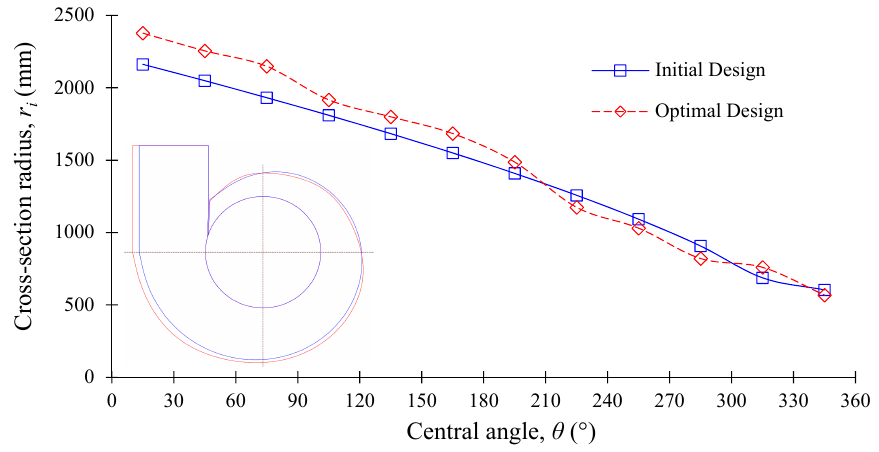
Figure 18. Comparison of initial and optimal casing design for the 100 MW class Francis turbine. Table 10. Results of casing optimization for the 100 MW class Francis turbine.